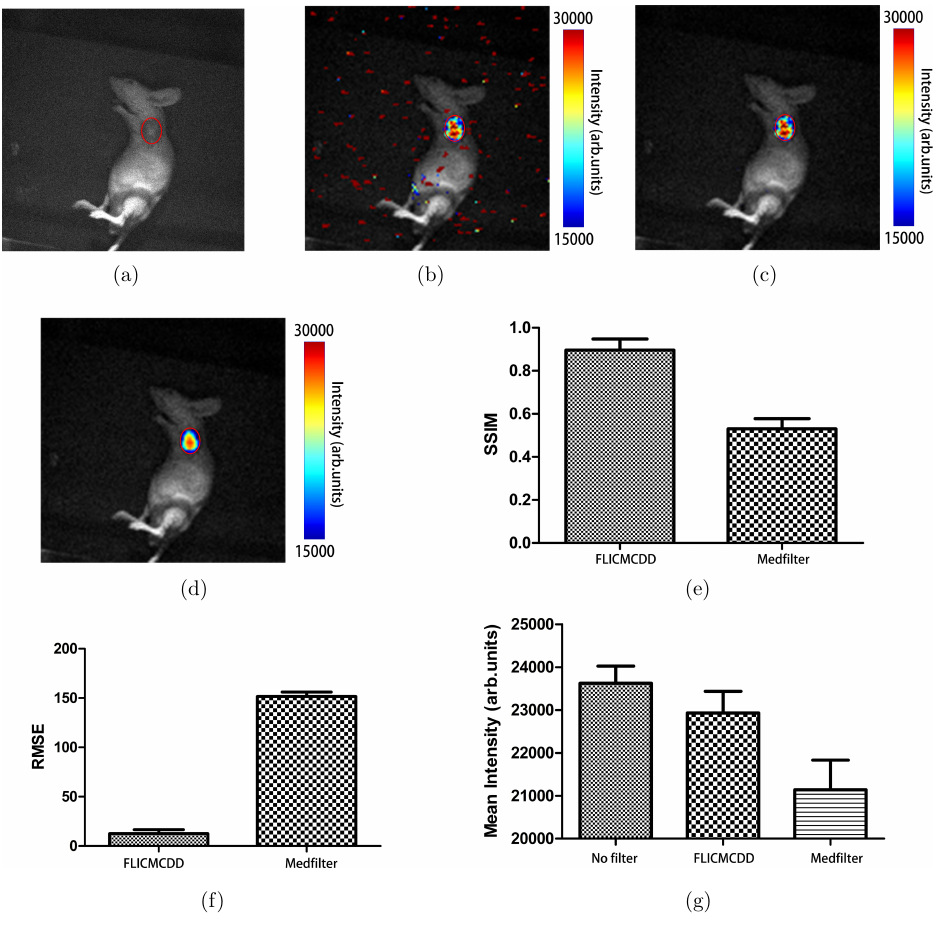
Fig. 5. Result of the in vivo experiment: (a) white-light image of mouse, the pseudotumor area is outlined in red circle; (b) original CLI image; (c) denoised CLI image by using FLICMCDD; (d) denoised CLI image by using median ¯lter; (e) comparison of SSIM (red circle) for FLICMCDD and median ¯lter; (f) comparison of RMSE for FLICMCDD and median ¯lter and (g) mean intensity of ROI of (b), (c) and (d),